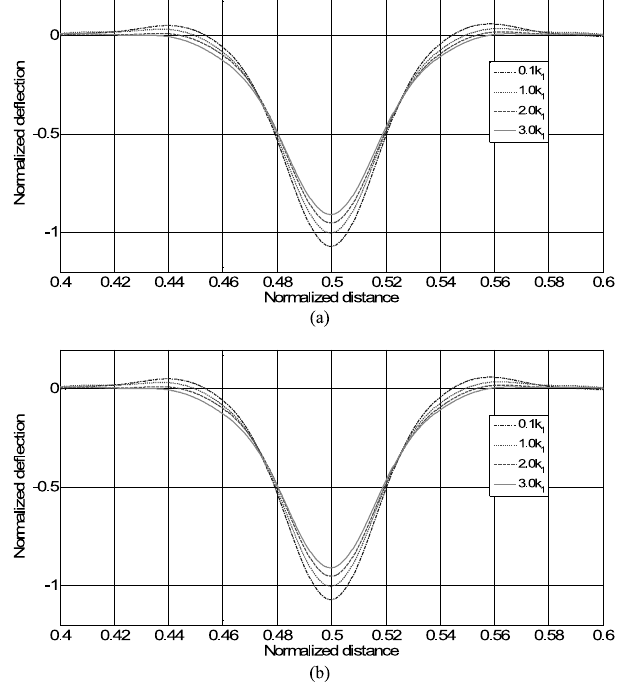
Fig. 9. Effect of shear modulus on dynamic de fl ection responses at a constant speed of 88.25 km/h; (a) moving load (b) moving